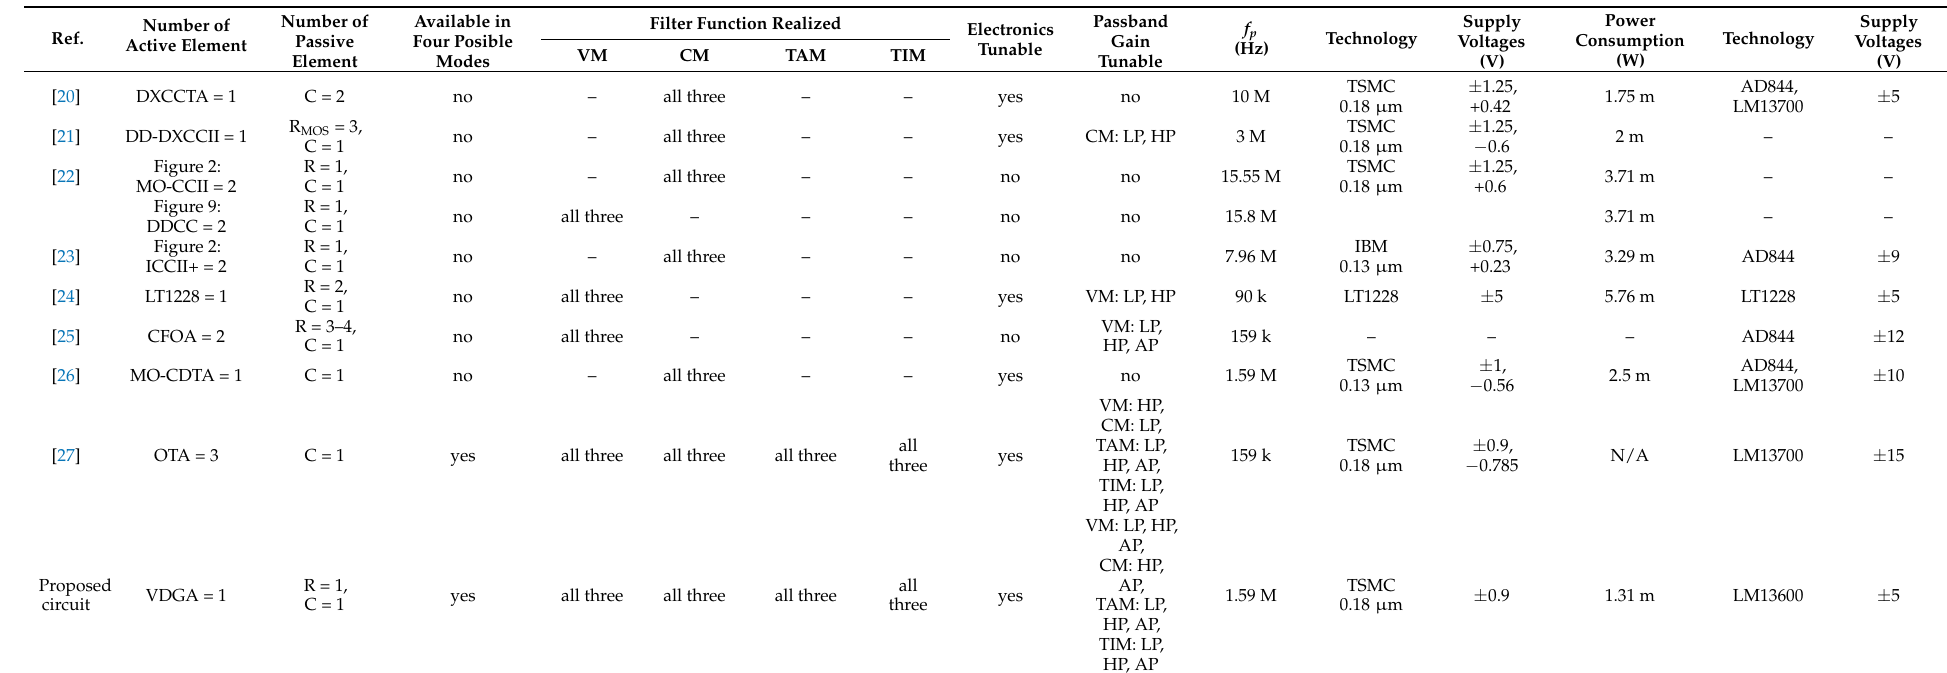
Figure 2: MO-CCII = 2 Figure 9: DDCC = 2 Figure 2: ICCII+ =